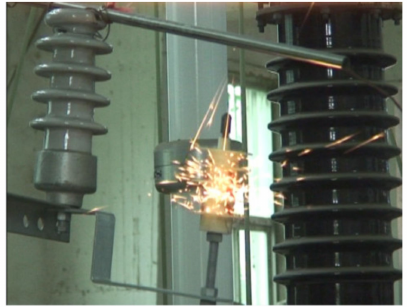
Figure 9. Action snapshot of the